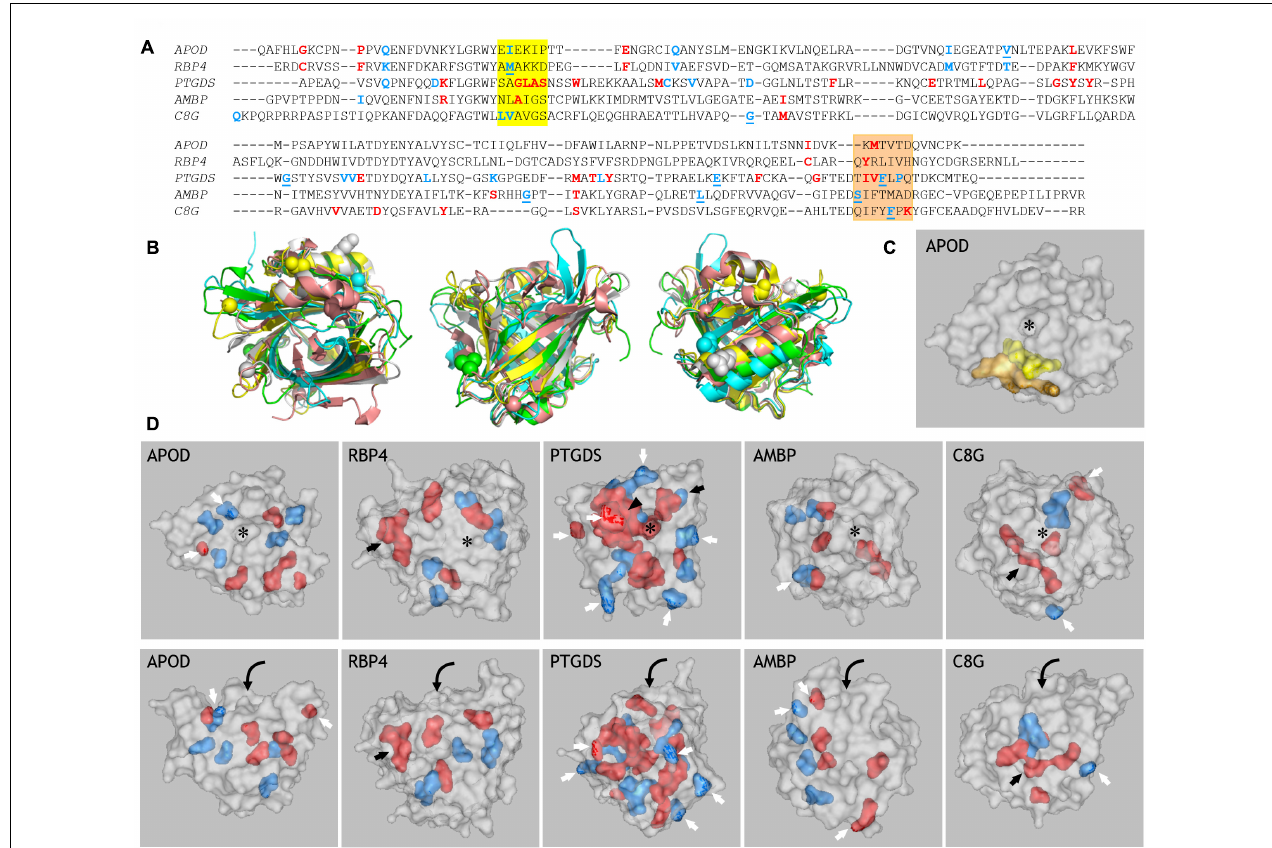
FIGURE 3 | Prediction of amino acid residues related to functional divergence in ED Lipocalins. (A) MSA of the five human representatives of the ED Lipocalins selected for this analysis. Residues related to Type-I divergence are labeled in blue, with underlined residues showing SSPP-probability support. Specificity-determining positions (SDPs) are labeled in red. Colored boxes mark two sequence regions enriched in functionally divergent residues. (B) Human Lipocalin structures superimposed, based on the structurally conserved beta-barrel, and colored (APOD, green; RBP4, cyan; PTGDS, gray; AMBP, yellow; C8G, salmon). Views into the ligand pocket, at the front side and the back side, revealing the alpha-helix attached to the beta-barrel, are shown. Colored spheres display SSPP-supported Type-I residues in all five Lipocalins. (C) Space-filled view of ApoD highlighting the residues marked by the two colored boxes in (A) . (D) Gray-colored space-filled views of the five human Lipocalin structures showing the color-coded residues identified in (A) . Panels in the upper row show views into the Lipocalin hydrophobic pocket (asterisk) while panels in the lower row show side views of the beta-barrel. Residues accessible at the protein surface (white arrows), or buried within the structure (black arrows) are pointed. Arrowhead points to a side wall of the binding pocket in PTGDS, and curved arrows suggest the binding pocket entrance on the side views of